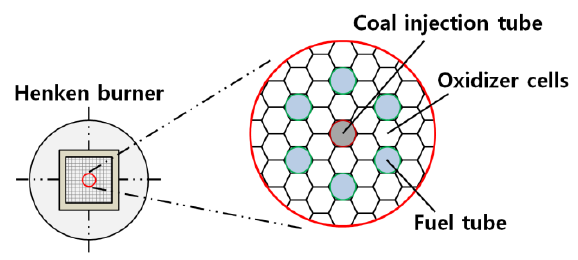
Figure 2. Schematic of the cross-sectional area of a Henken burner.